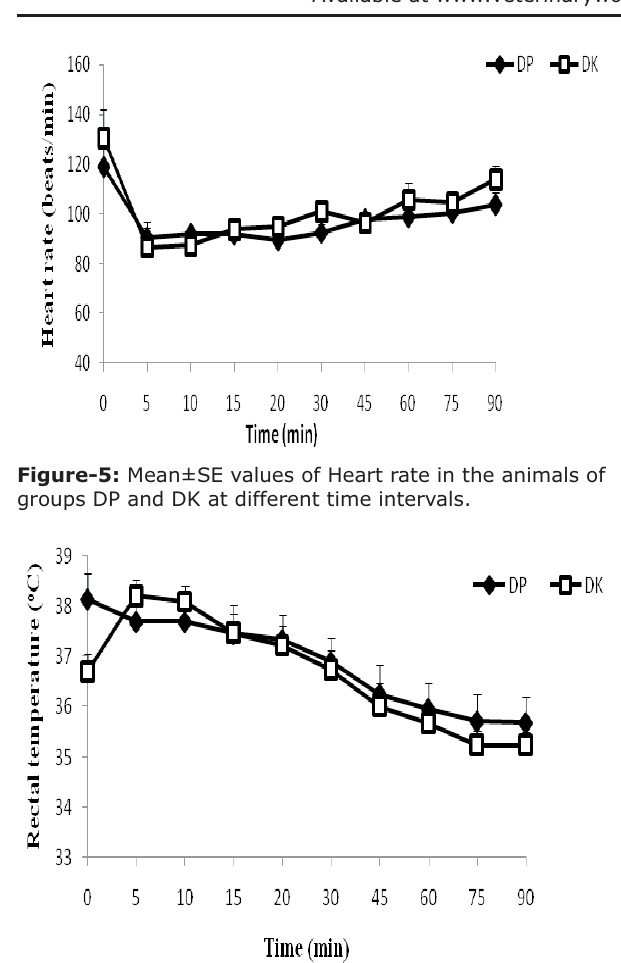
Figure-7: Mean±SE values of rectal temperature in the animals of groups DP and DK at different time intervals.